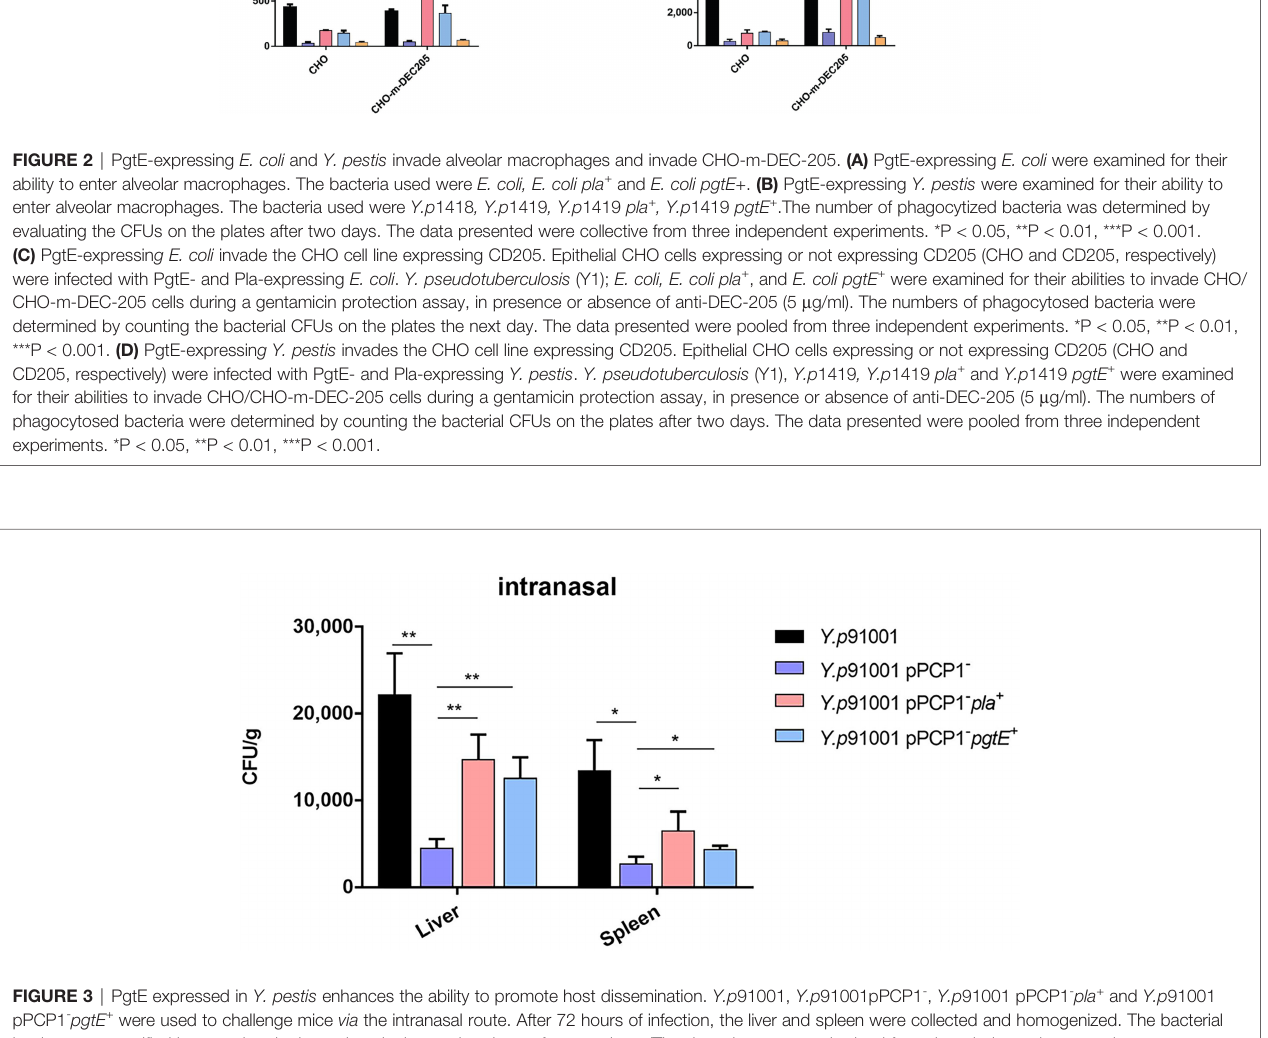
loads were quanti fi ed by counting the bacteria colonies on the plates after two days. (The data shown were obtained from three independent experiments. *P < 0.05, **P < 0.01.